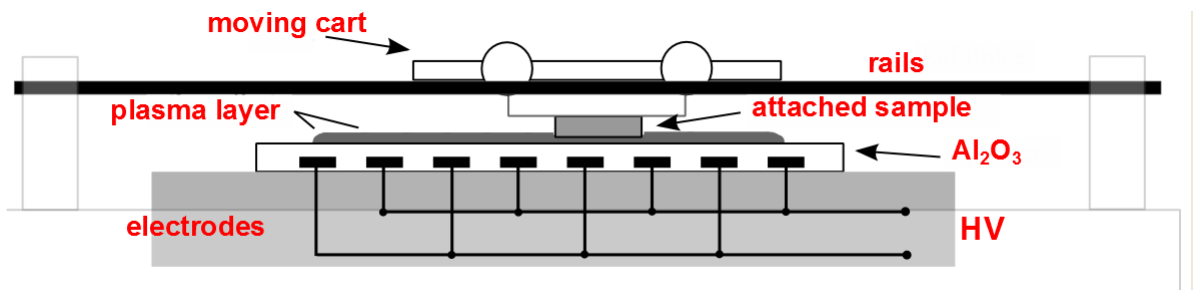
Figure 1 : DCSBD plasma treatment.